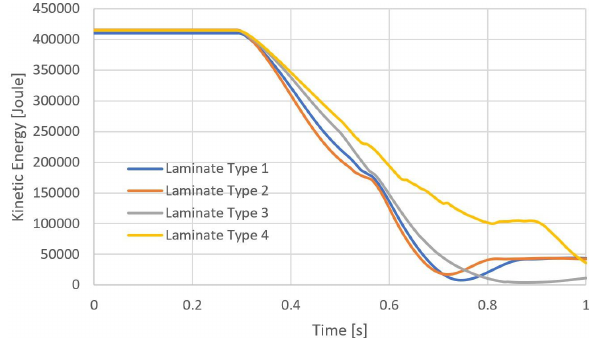
Figure 24: Geometric model of ship and harbor quay collision simu- lation